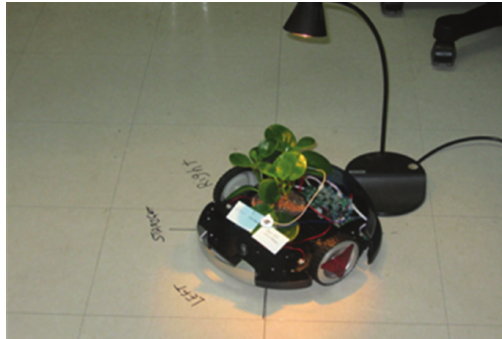
Figure 14: Prototype of